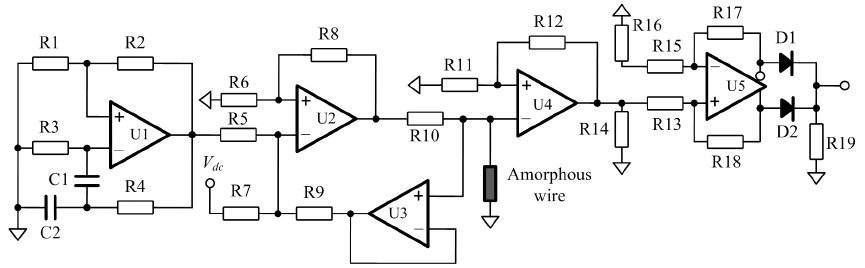
Figure 3. The GMI sensor circuit schematic.